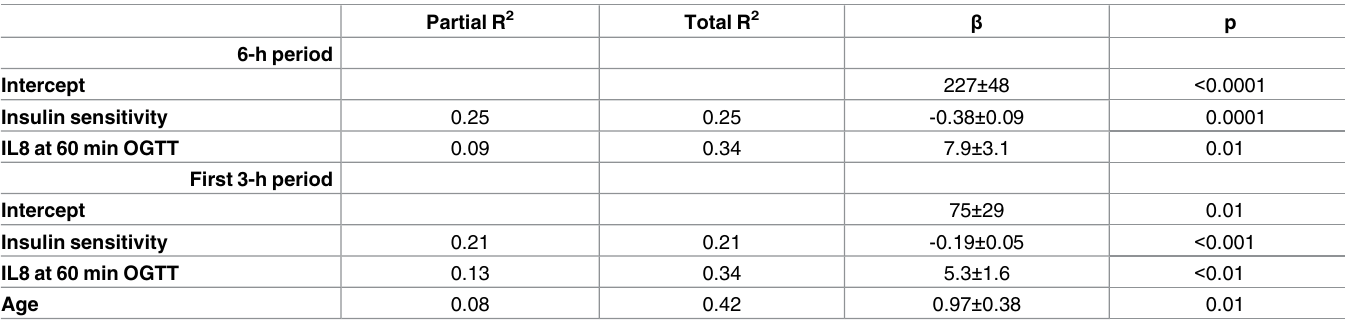
Table 4. Multiple regression model of glucose-stimulated insulin